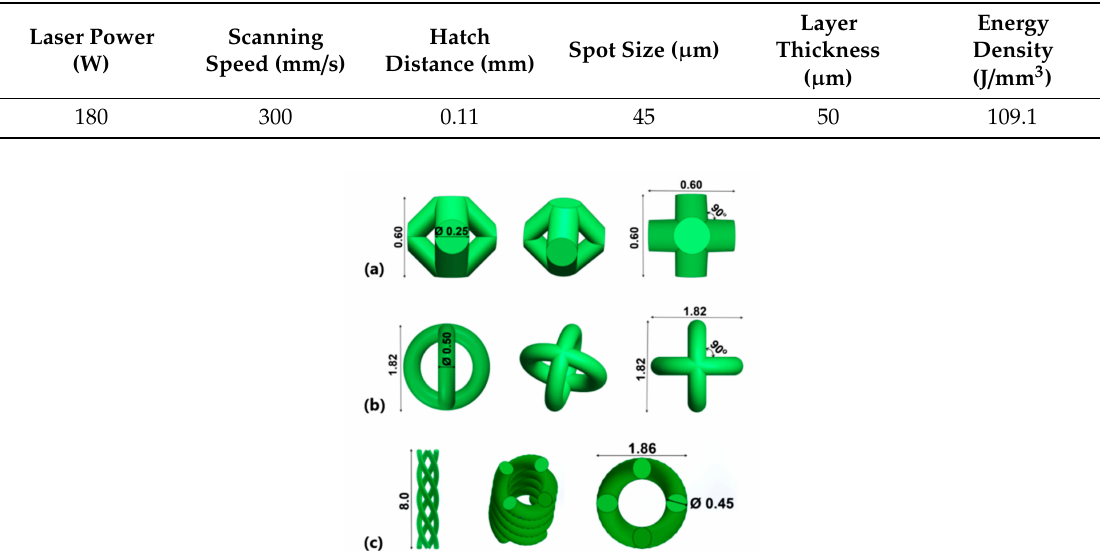
Selective laser melting (SLM) parameters configured to manufacture the Ti6Al7Nb lattice specimens.